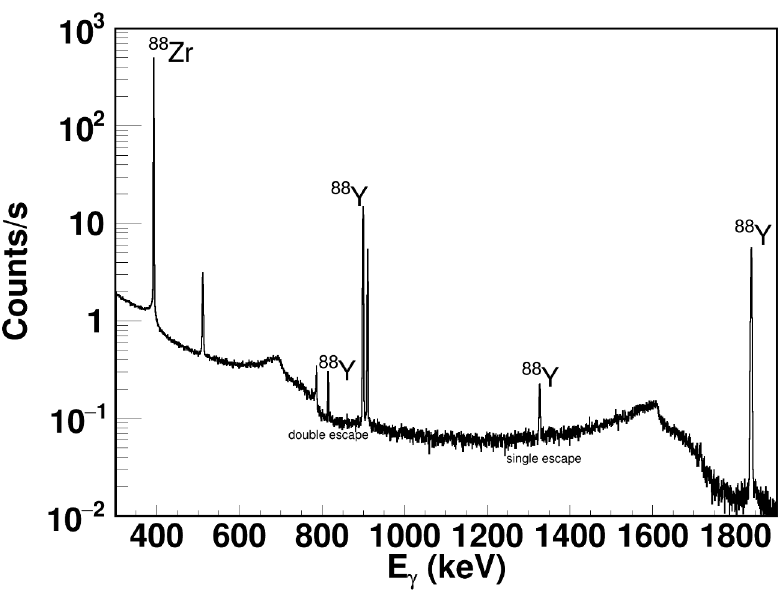
Figure 5. Gamma ray spectrum of 25 µ L of the sample taken with an HPGe detector. Only the 88 Zr and 88 Y gamma rays along with their escape peaks are labeled.